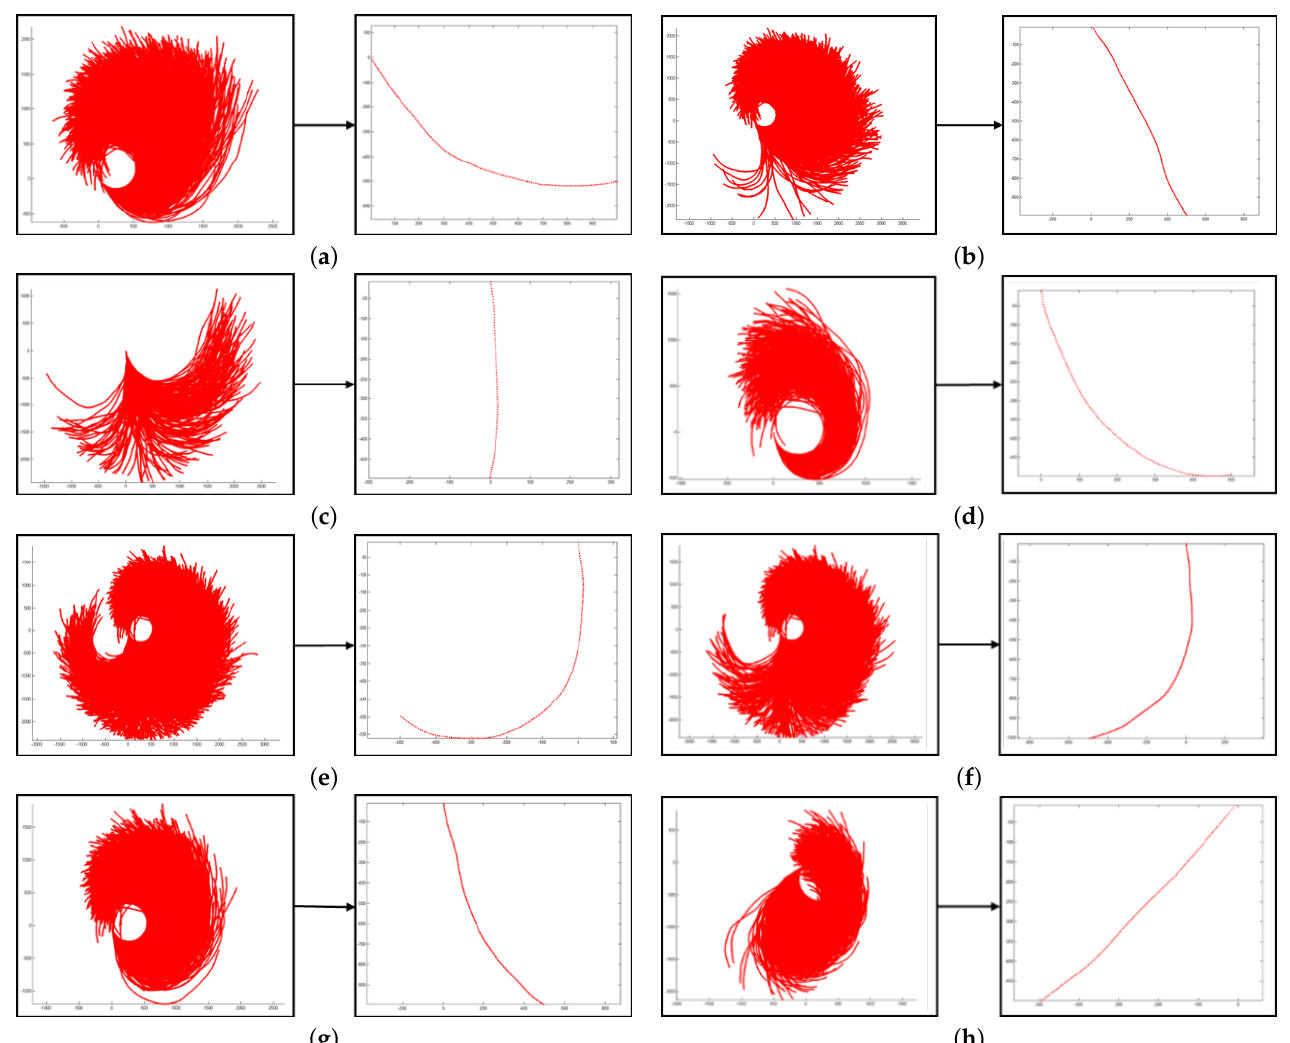
Figure A2. Regularization-trajectory cell library: the second section. ( a ) Time-varying trajectory cell from the initial 135 ◦ direction to 90 ◦ (rudder angle is − 5.32°). ( b ) Time-varying trajectory cell from the initial 135 ◦ direction to 180 ◦ (rudder angle is 3.8°). ( c ) From the initial 180 ◦ direction to the 180 ◦ time-varying track cell (rudder angle is − 0.78°). ( d ) Time-varying trajectory cell from the initial 180 ◦ direction to 90 ◦ (rudder angle is − 22.78°). ( e ) Time-varying trajectory cell from the initial 180 ◦ direction to 270 ◦ (rudder angle is 4.33°). ( f ) Time-varying trajectory cell from the initial 180 ◦ direction to 225 ◦ (rudder angle is − 0.05°). ( g ) Time-varying trajectory cell from the initial 180 ◦ direction to 135 ◦ (rudder angle is − 9.61°). ( h ) From the initial 225 ◦ direction to the 225 ◦ regularization-trajectory cell (rudder angle is −